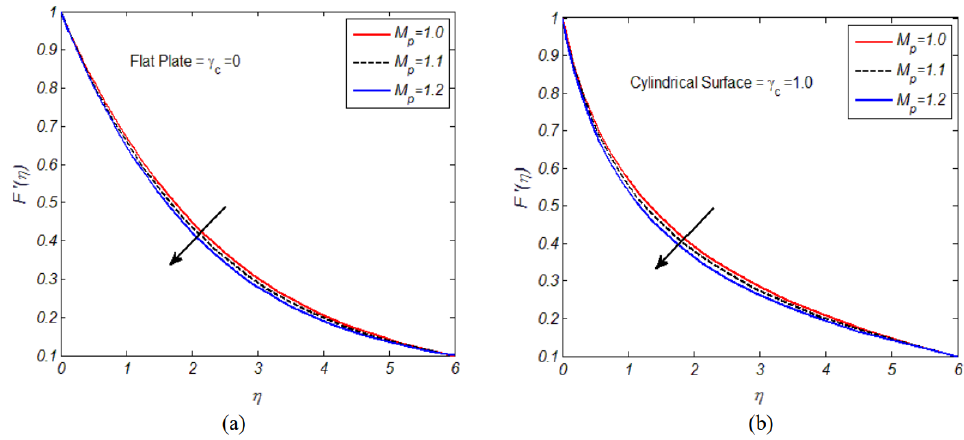
M on velocity at fl at surface; ( b ) Impact of p